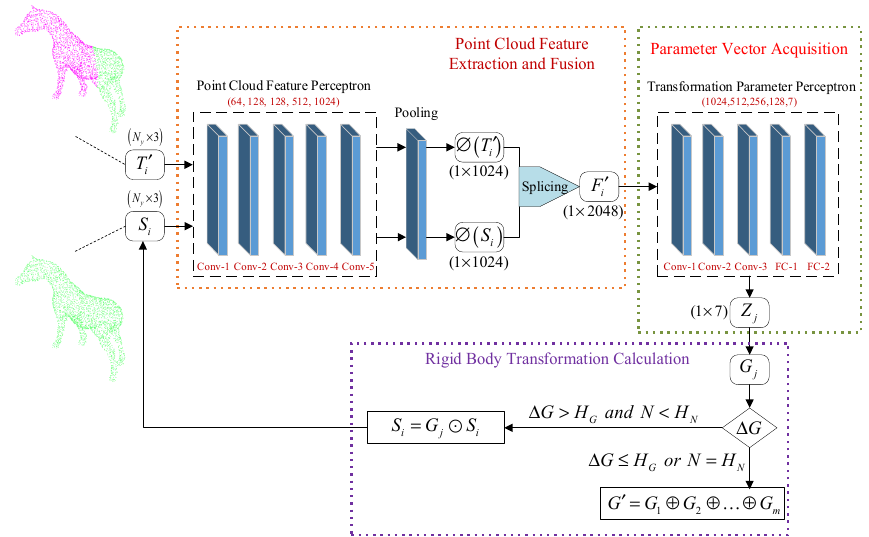
Figure 4. The network architecture of the TMPE-Net.